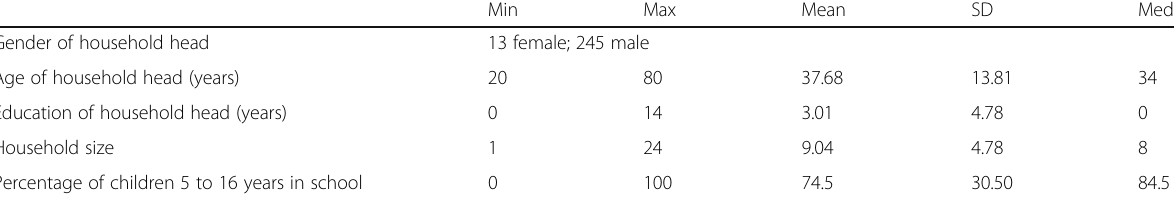
Table 2 Socio-demographic characteristics of the household questionnaire sample ( n = 258) Min Max Mean SD Median Gender of household head 13 female; 245 male Age of household head (years) Education of household head